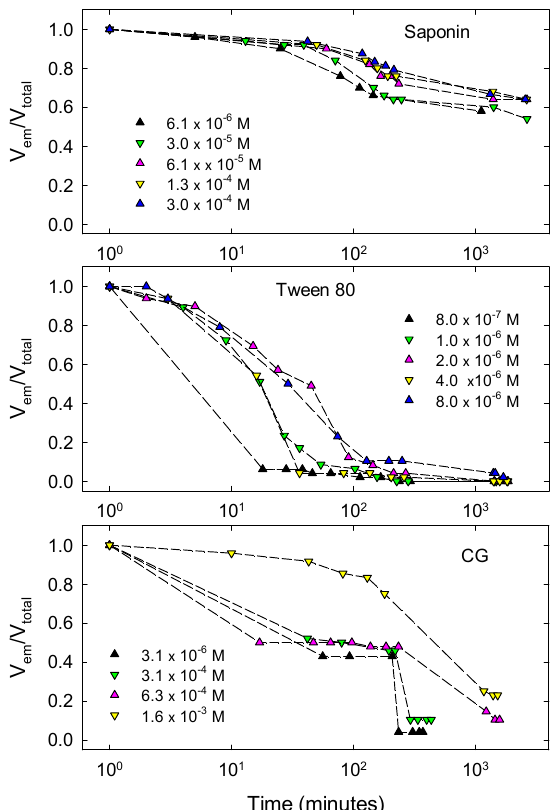
Figure 8. Evolution of the relative oil-in-water emulsion volume for different concentrations of the aqueous surfactant solution before emulsification. Results obtained by the Double Syringe technique using two 5 mL syringes, 20 manual pushing cycles and volume ratio V oil : V water = 1:1.